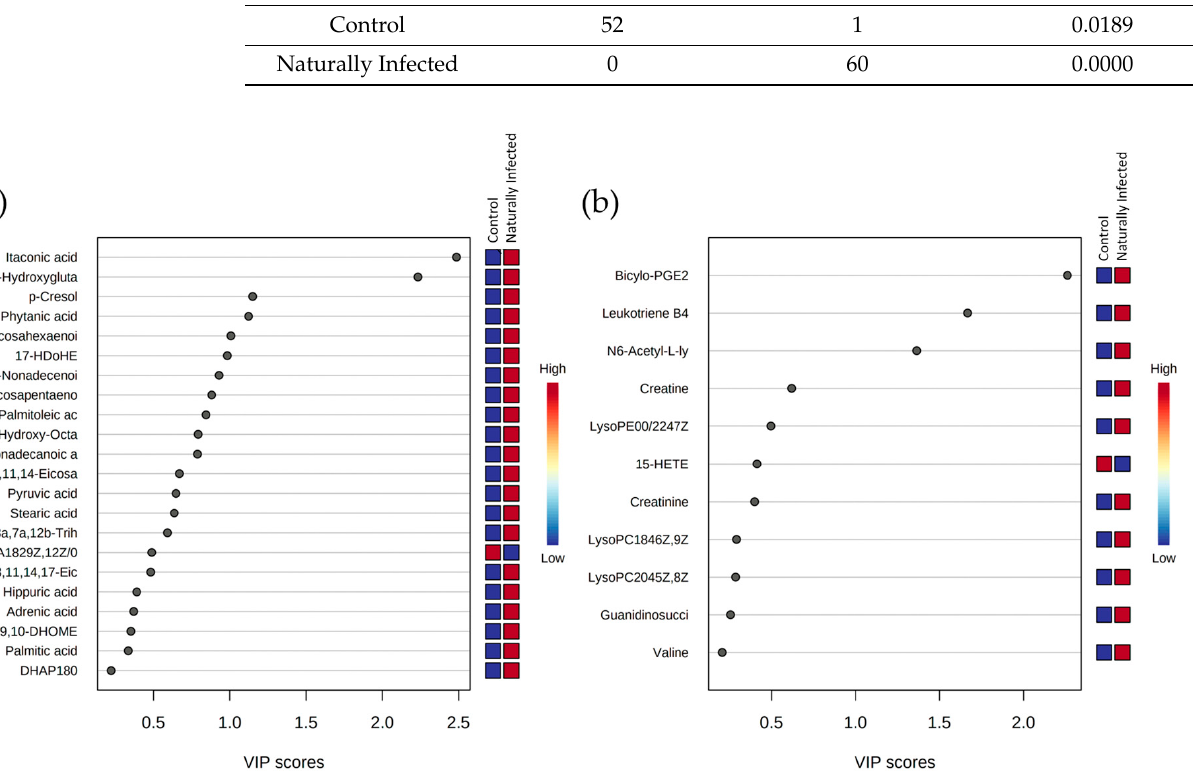
Figure 2. Variable importance in projection (VIP) score plots based on two components from the partial least-squares discriminant analysis (PLS-DA) of metabolites differentially expressed in naturally MAP-infected and control heifers in the ( a ) negative ionization mode m/z and ( b ) positive ionization mode m/z